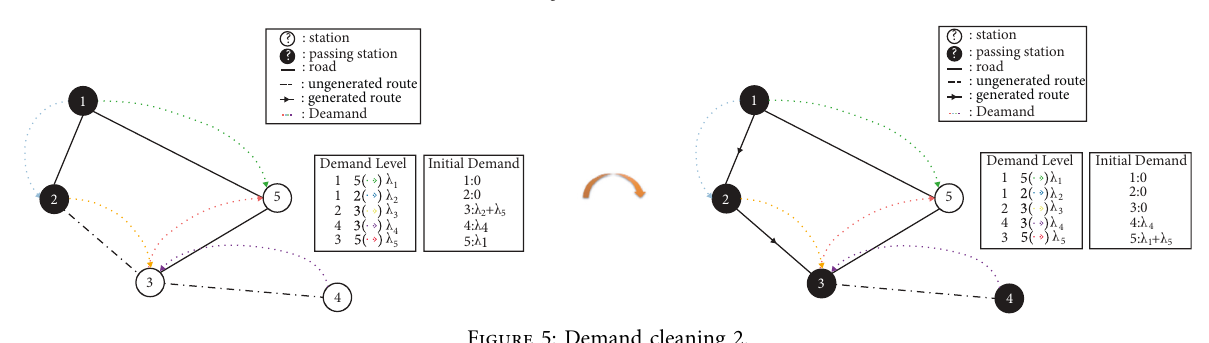
Figure 5: Demand cleaning